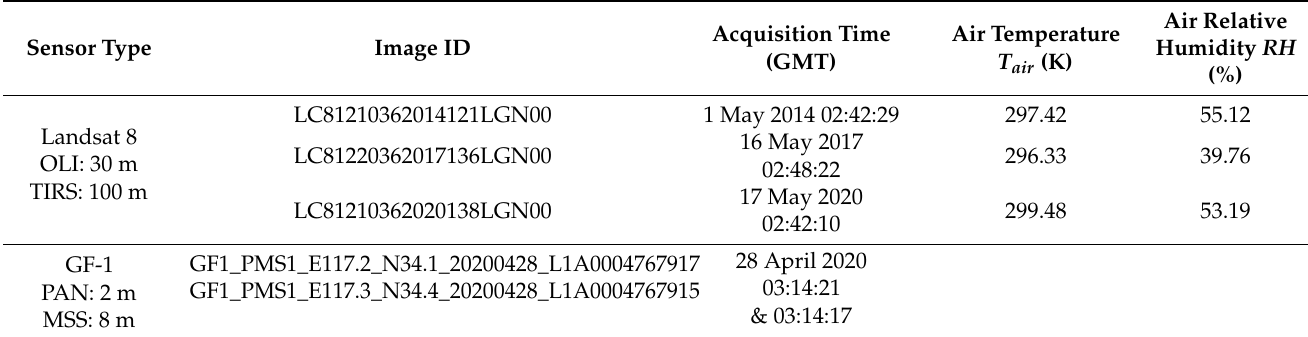
Table 1. Remote sensing data information and ground meteorological observation